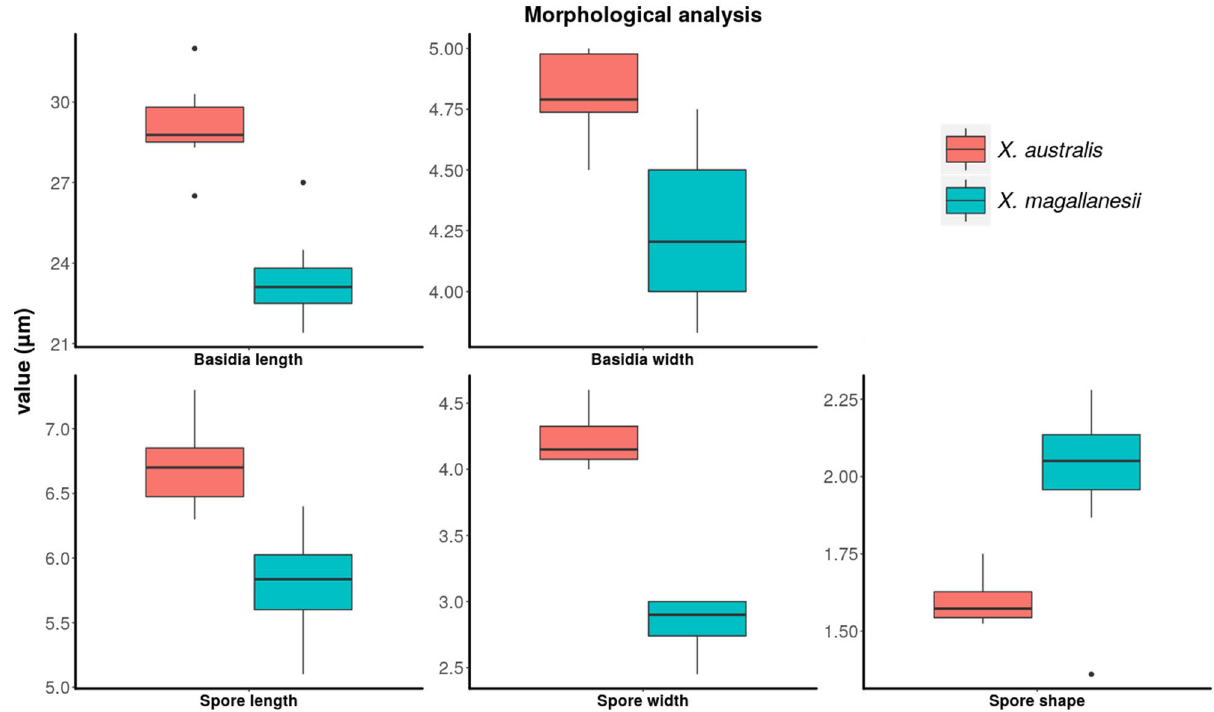
Figure 1. Morphological analyses conducted for basidia length and width, and spore length, width and length/ width relation. Graphs were generated using R Core Team v3.6.1 (https ://www.R-proje